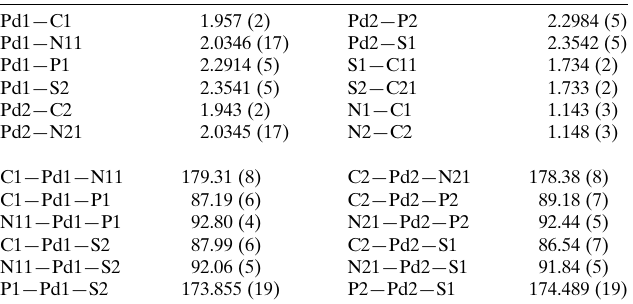
Table 2 Selected geometric parameters (A˚ , (cid:5) ) for 2 .